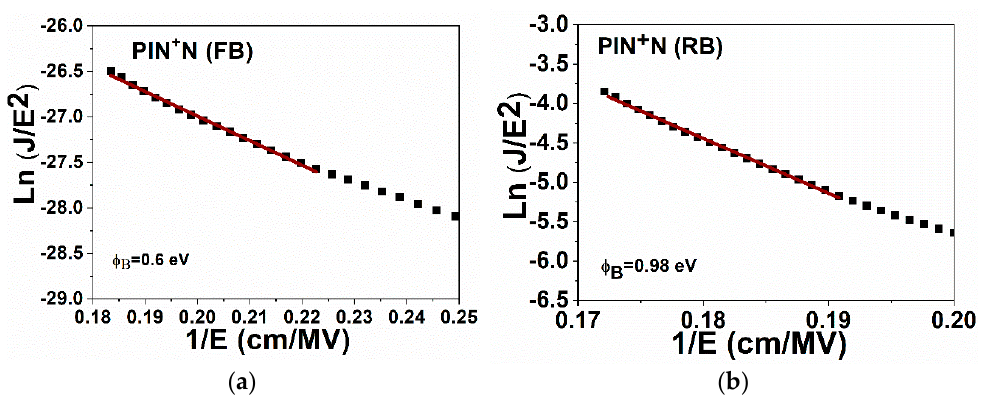
Figure 8. Ln (J/E 2 ) vs. 1/E for: ( a ) forward bias and ( b ) reverse bias of device PIN + N.